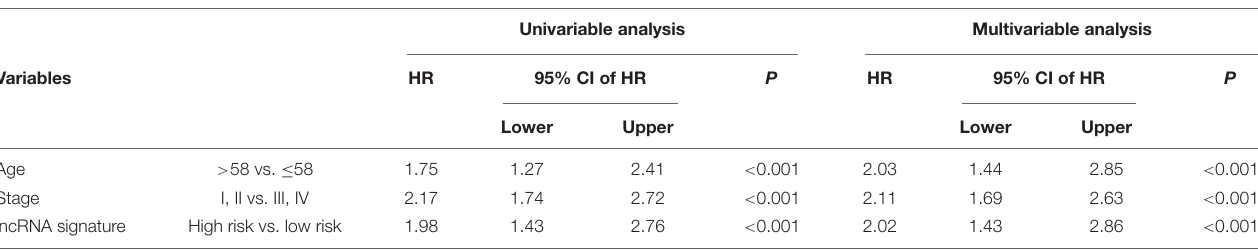
FIGURE 5 | Survival prediction performance of the four-lncRNA signature (AP000851.1, LINC01977, MAFG-DT, and SIAH2-AS1). (A) Kaplan–Meier curves for BRCA patients stratified by the four-lncRNA signature. P -values were calculated using a log-rank test. (B) ROC analysis to assess the survival accuracy of the four-lncRNA signature for 1, 3, 5, and 10 years of survival. TABLE 3 | Cox regression analysis of the signature with BRCA survival ( n =